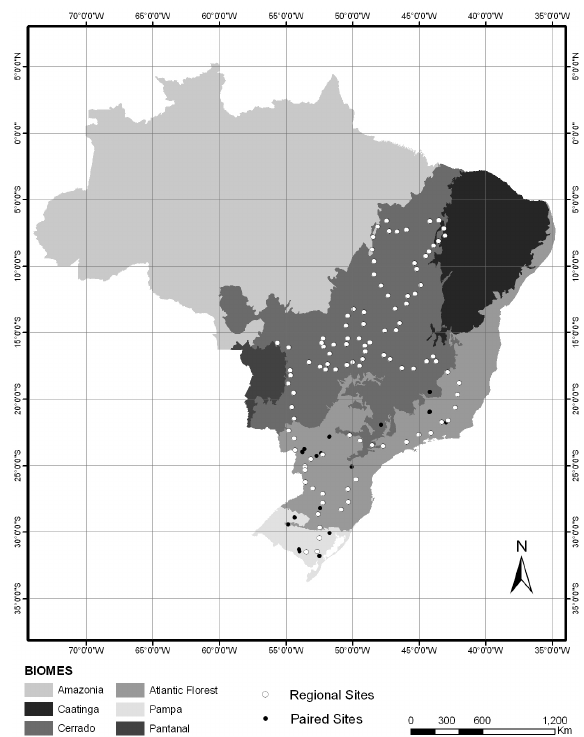
Figure 1. Sampling sites located throughout Brazil. White circles indicate pasture sites of the regional survey; black circles indi- cate paired study sites, and various shaded areas indicate Brazilian